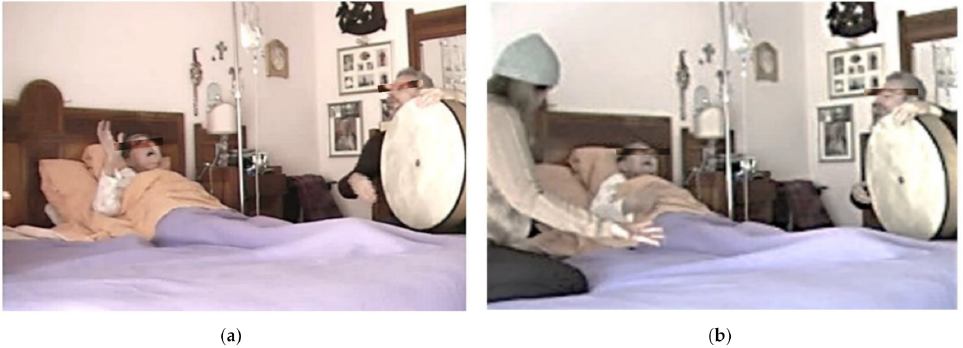
Figure 4. ( a ) In this picture, you can see Tina on the left, the patient, in her bad playing and singing with the conductor Raffaele Schiavo on the right. ( b ) This other picture, compared to previous one, includes the presence of Tina’s daughter on the left, as new guest performer on the